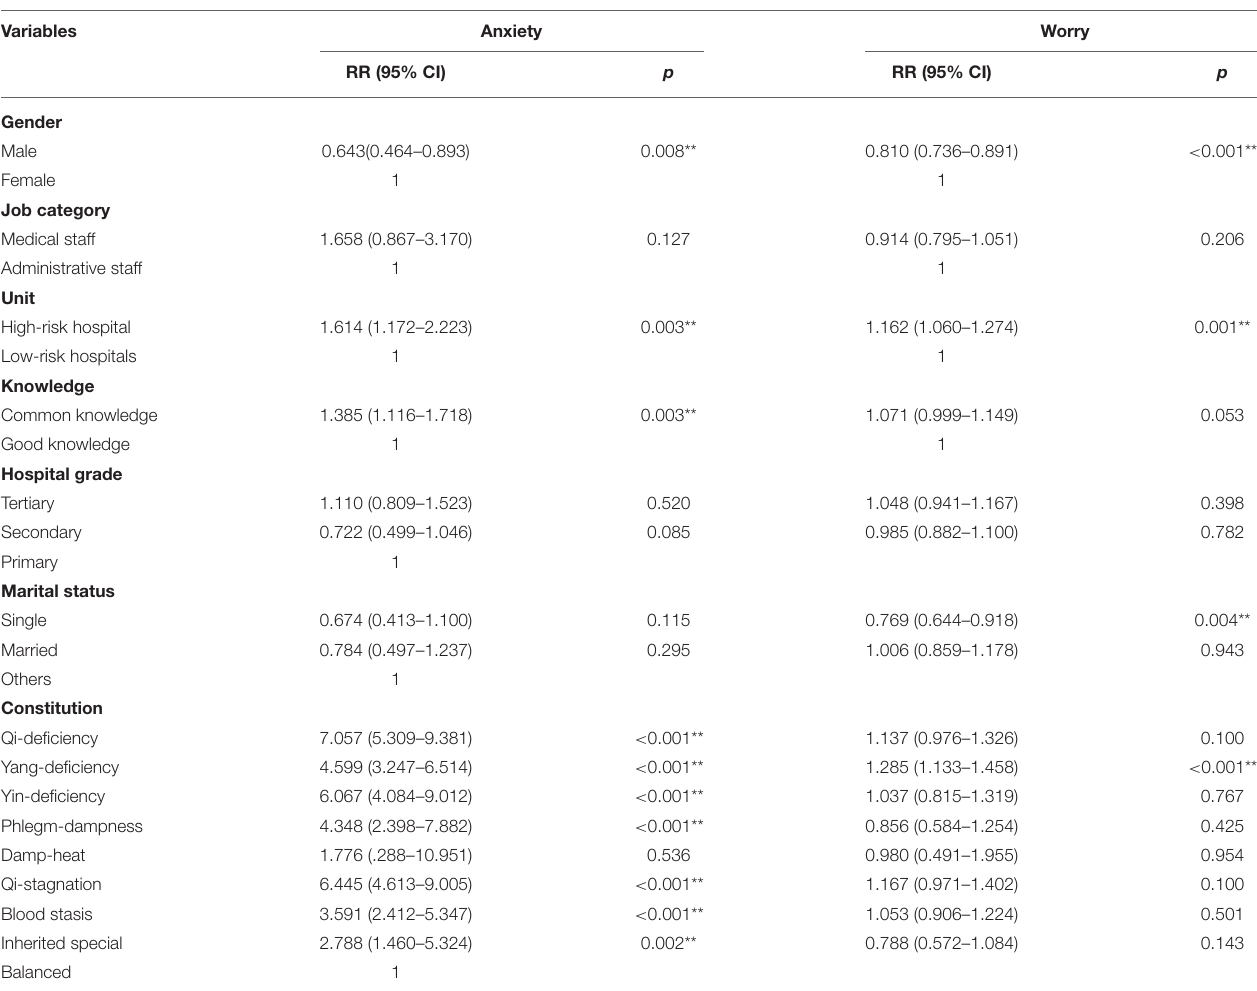
TABLE 5 | Multivariable analysis of anxiety and worry based on different